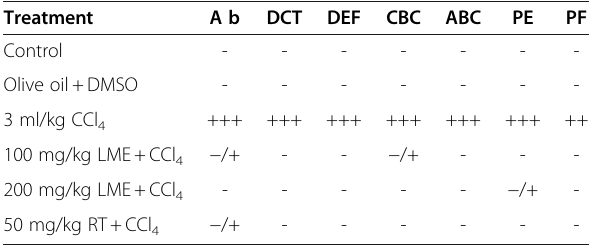
were also clearly observed (Figure 3A). The alveolar macro- phages were also prominent and the alveolar bronchioles show their normal shape with inner epithelium. Treatment of CCl in the lungs induced the degeneration of the al- 4 veolar septa, disruption of the connective tissues, elastic fibers and the congestion of the blood capillaries which were also blocked with large aggregation of the blood cells (Figure 3B & C). Administrations of 100 mg/kg, 200 mg/kg LME and 50 mg/kg b.w. RT reduced the toxic effects of CCl and reduced injuries were observed in the lung tissues 4 of these groups. The ameliorating effects of the frac- tions were more pronounced at the higher dose of LME (Figure 3D, E & F). Most areas of the lungs showed the normal alveolar spaces, alveolar and bronchioles with minor cell degeneration, PNI, PNII but a less marked thickening was still observed in the intralveo- lar septum (Table 4).